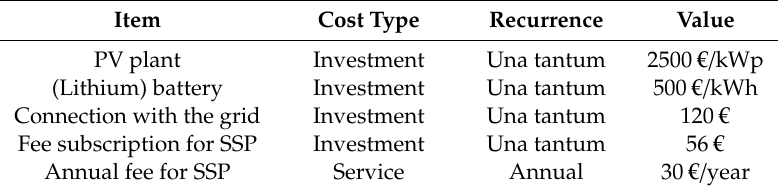
Table 8. Costs of PV installation, subscription to the net-metering service and dismission.